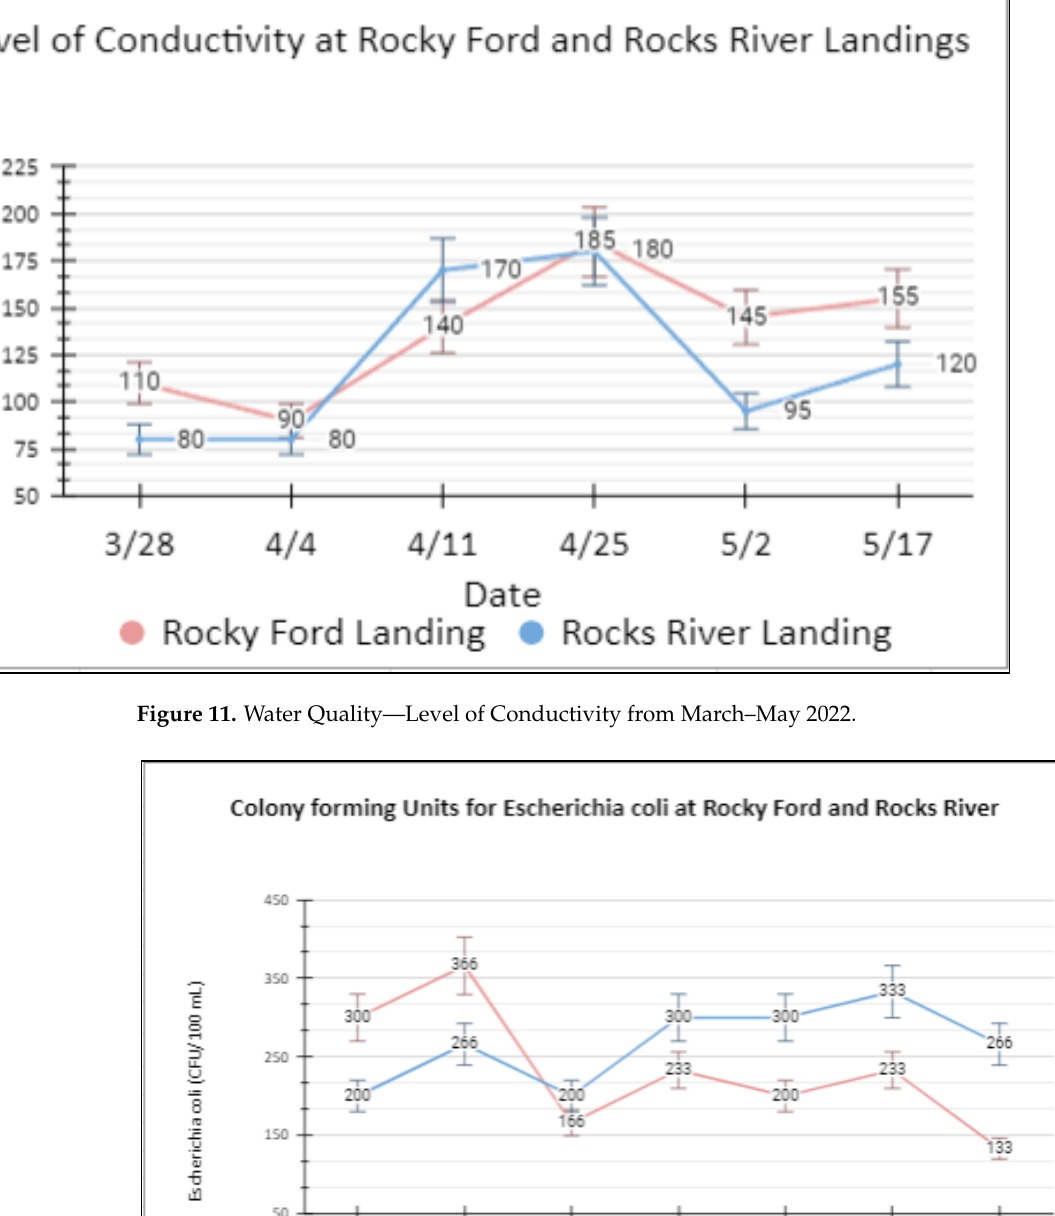
Figure 10. Water Quality — Dissolved Oxygen Level Measurements from March – May 2022.